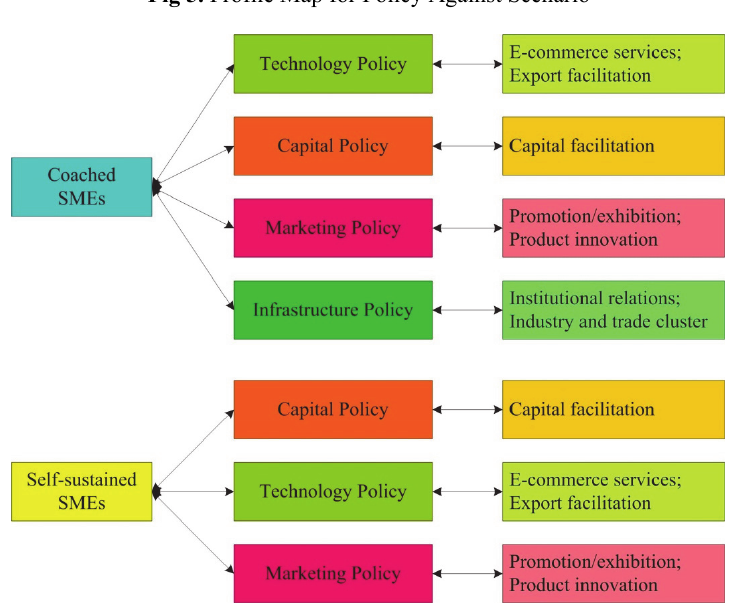
Fig 6. Potency of Policy Path and